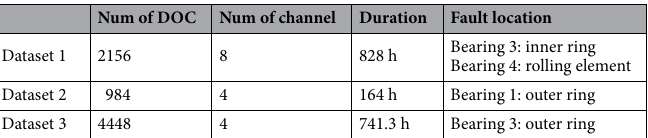
Table 1. Description of three datasets.